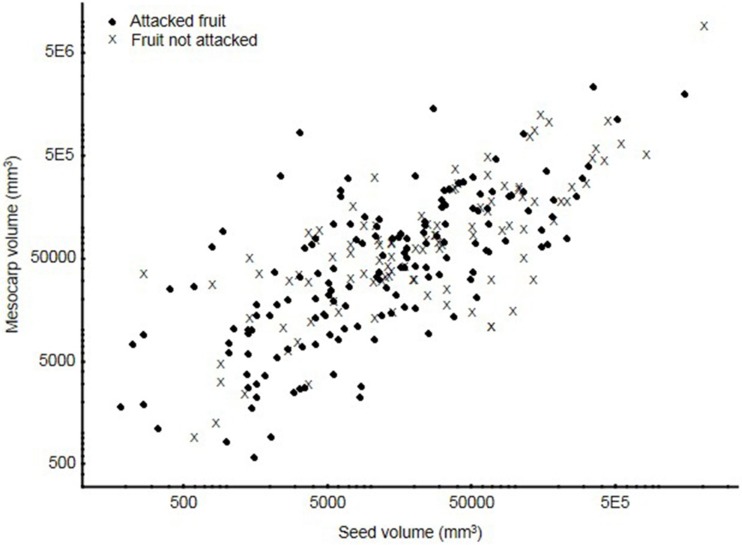
Relationship between seed and mesocarp volume for 268 plant species attacked and not attacked by Lepidoptera.